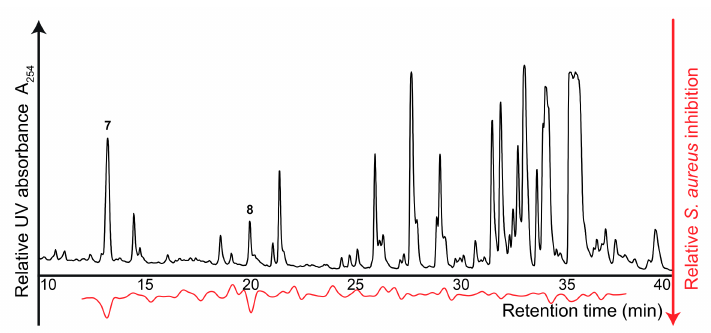
Figure 6. HPLC chromatogram at 254 nm of the crude extract of A. montevidensis , separated on a C 18 column. The corresponding high-resolution S. aureus growth inhibition profile is shown below in red, pinpointing compounds 7 and 8 as S. aureus growth